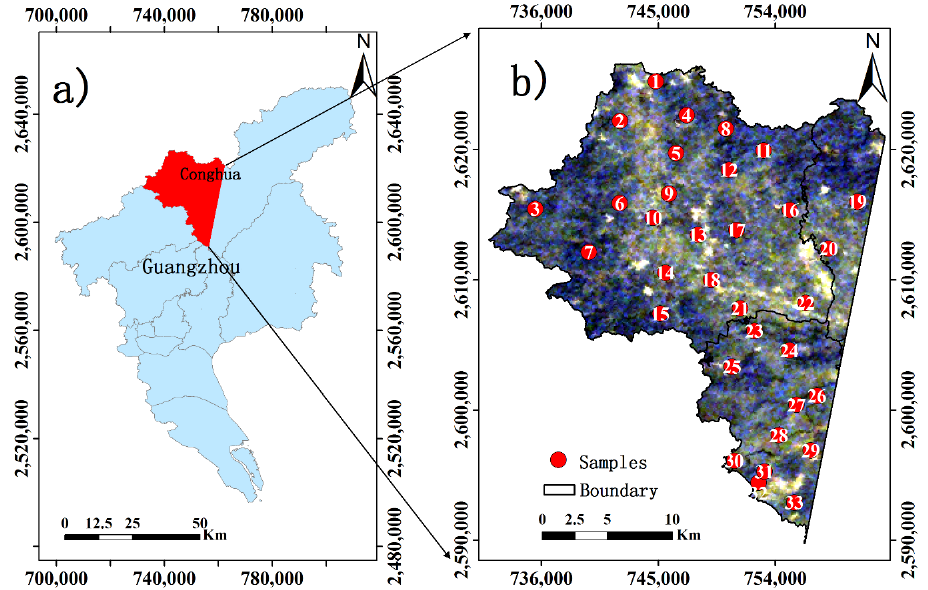
Figure 2. ( a ) The location of the testing study area in Guangzhou city and ( b ) the area shown using the HJ-1A HSI image with the spatial distribution of the 33 test soil samples (red dots).